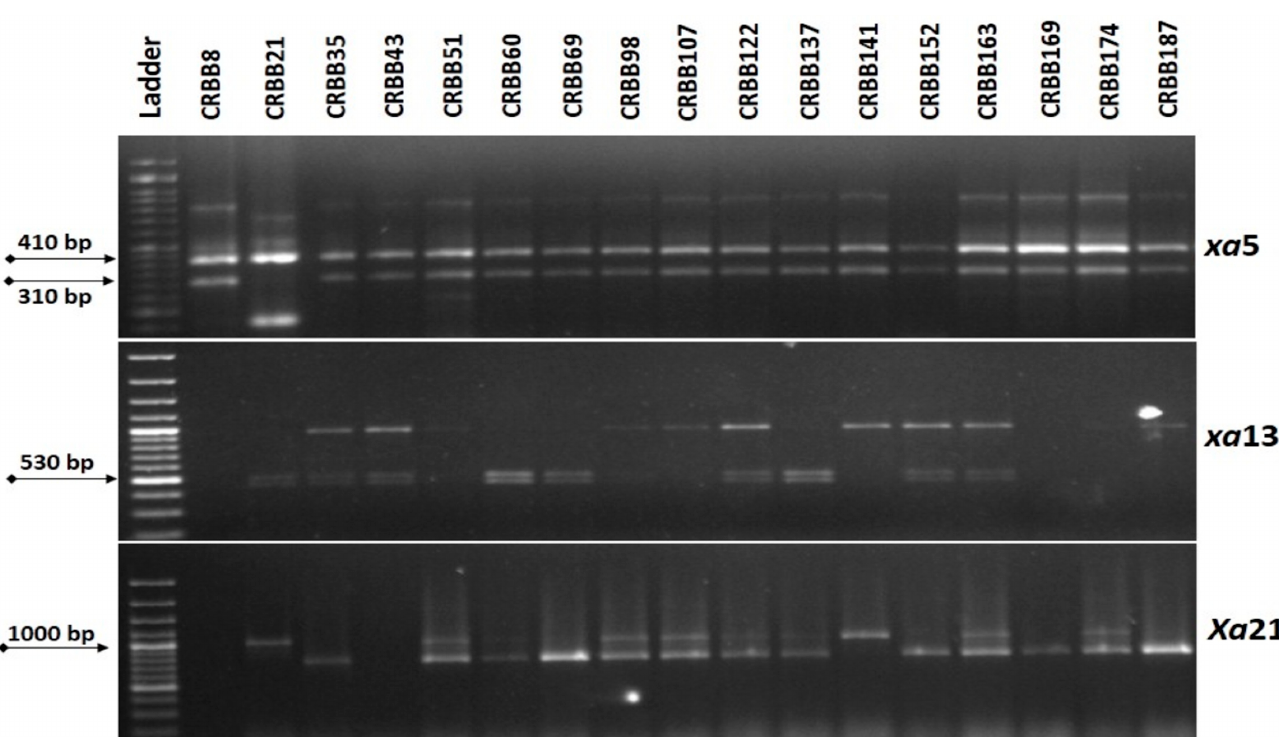
Figure 2. Representative electropherogram generated from the tracking of Xa21 , xa13 and xa5 BB resistance genes in BC 1 F 1 progenies of resistance gene pyramiding of Ranidhan.